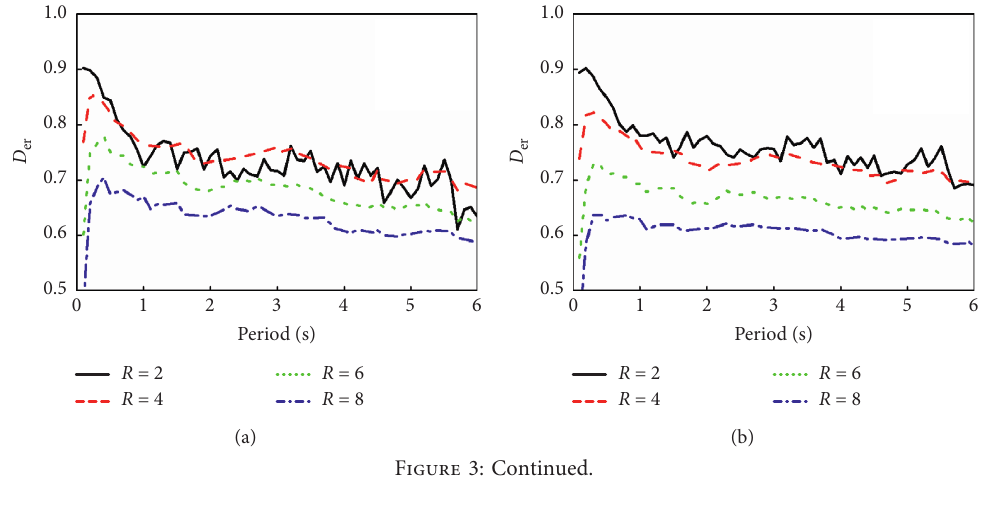
� 22. (b) I � 14. (c) I � 5. (d) D D D